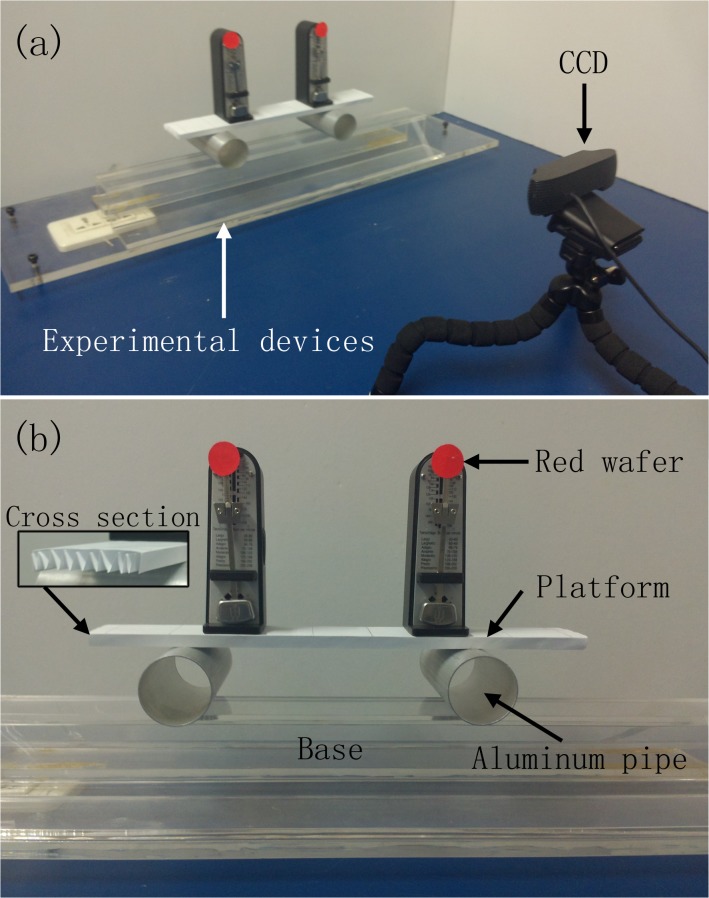
The experimental setup.(a) The experimental equipment and the CCD acquisition system. (b) The details of the experimental equipment.